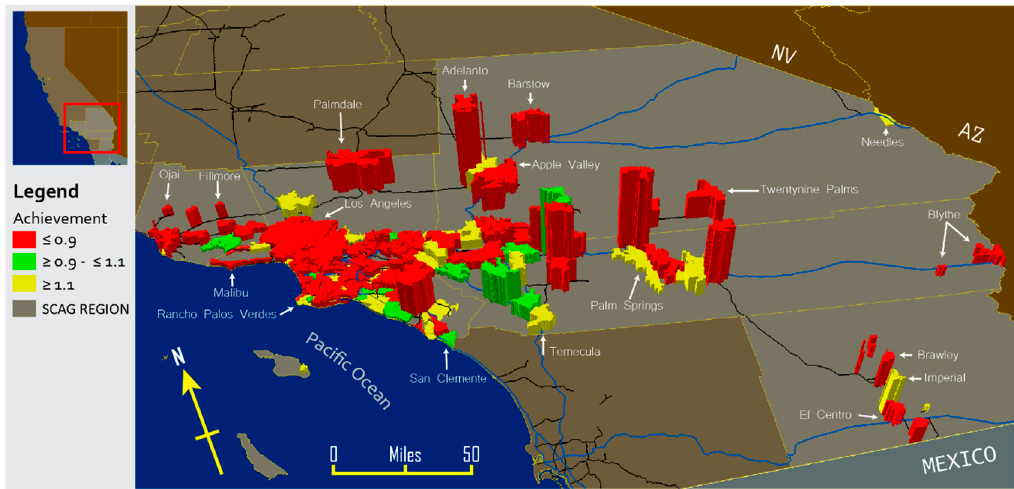
Figure 7. Map of the Los Angeles Region Cities by achievement. This map illustrates that many cities achieved less than 90% of their assigned housing growth (e.g., Adelanto, Brawley, Fillmore, Malibu, Ojai, Palmdale). In addition, very few of the high-growth cities (e.g., Imperial) achieved more than 90% of their assigned housing growth. Lastly, the cities that achieved their housing growth were low-growth and coastal cities (e.g., Rancho Palos Verdes, San Clemente) or low-growth and inland (e.g., Needles, Palms Springs, Temecula). Note that the extrusion heights are not to scale. Source. SCAG.